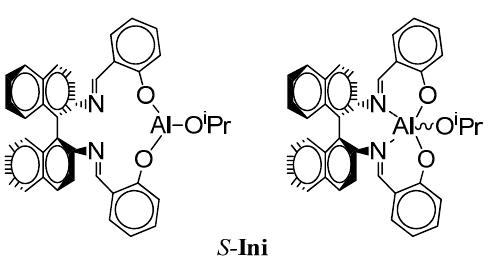
Scheme 2. Structure